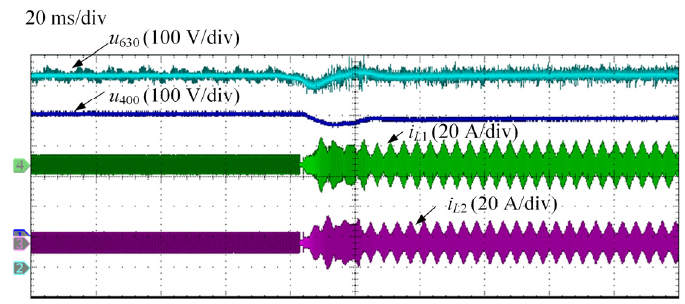
Figure 21. Waveforms of AC load transition from 0 to 7 kW in off-line mode.